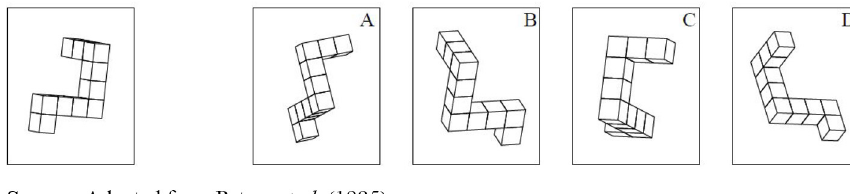
Figure 4. A common task on mental